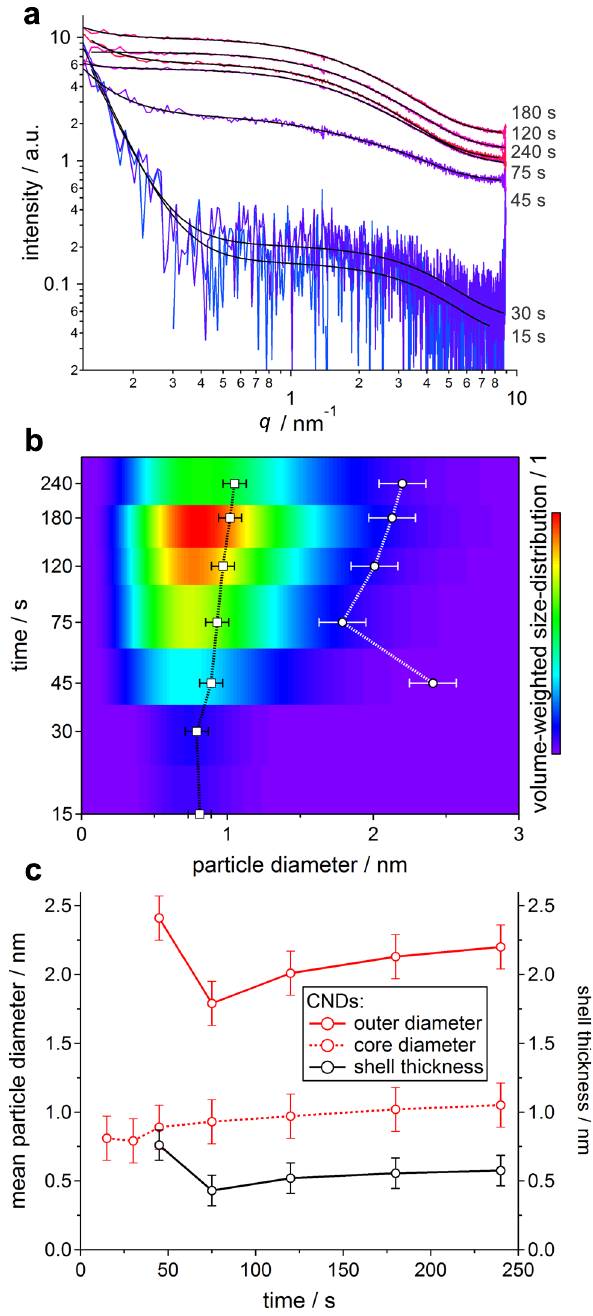
Fig. 2 Nano-structural evolution. a SAXS patterns and model- fi ts (black) of CNDs at 15 – 240 s. b Volume-weighted size distribution of CNDs, in comparison to the mean particle diameter (black trace) as well as the mean CND spacing (white trace). c Nanoparticle diameter as well as mean CND spacing (interaction distance – mean particle diameter) of CNDs and RM, obtained from SAXS pattern fi ts. Error bars denote the mean fi tting uncertainty over all data sets, which is (in relative terms) <10% and <20% for fi tted (core- and outer-diameter) and derived (shell thickness) parameters,